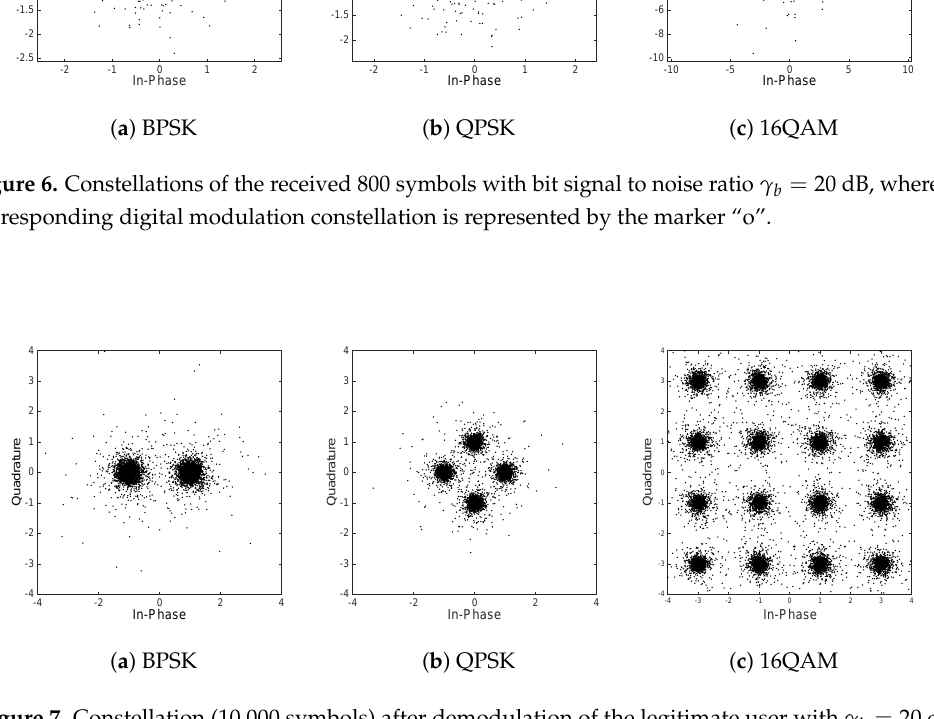
Figure 7. Constellation (10,000 symbols) after demodulation of the legitimate user with γ b = 20 dB.